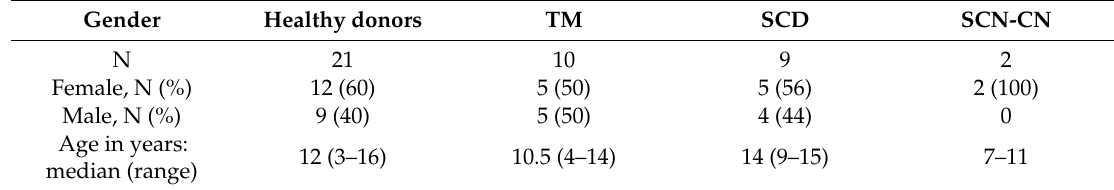
Table 1. Characteristics of patients with non-malignant hematological diseases and healthy